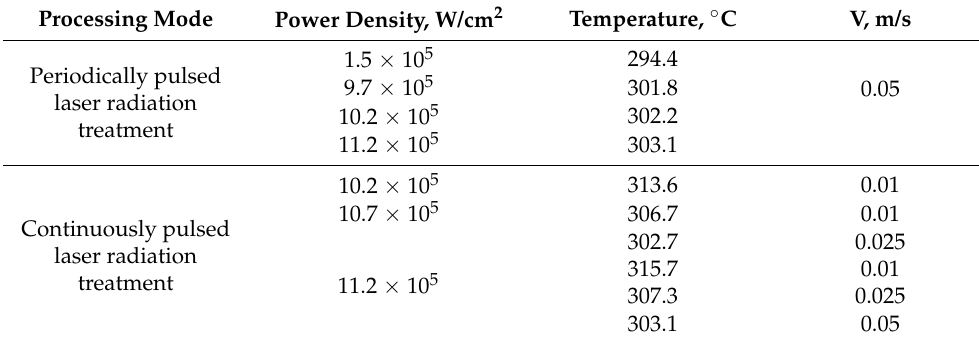
Table 1. Nd:YAG laser parameters used to calculate the temperature. Processing